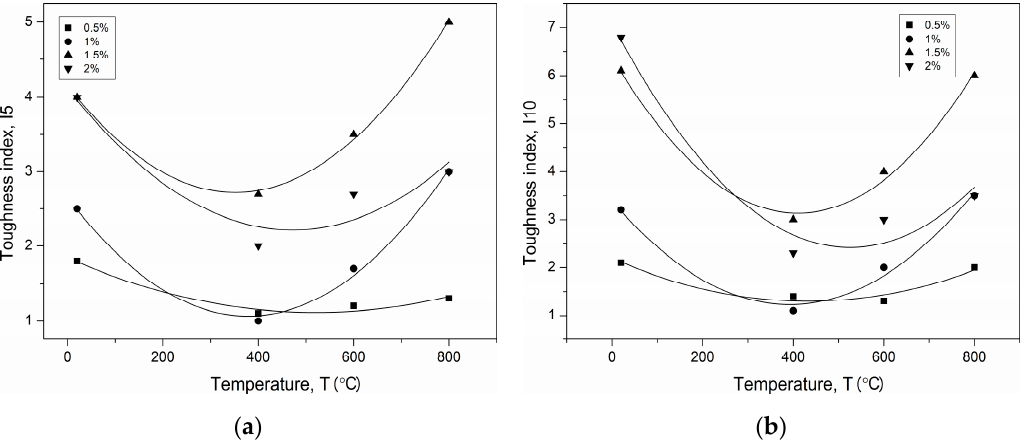
Figure 8. Temperature–toughness indexes fitted curves of PPF-reinforced UHPC ( a ) I5, ( b ) I10.